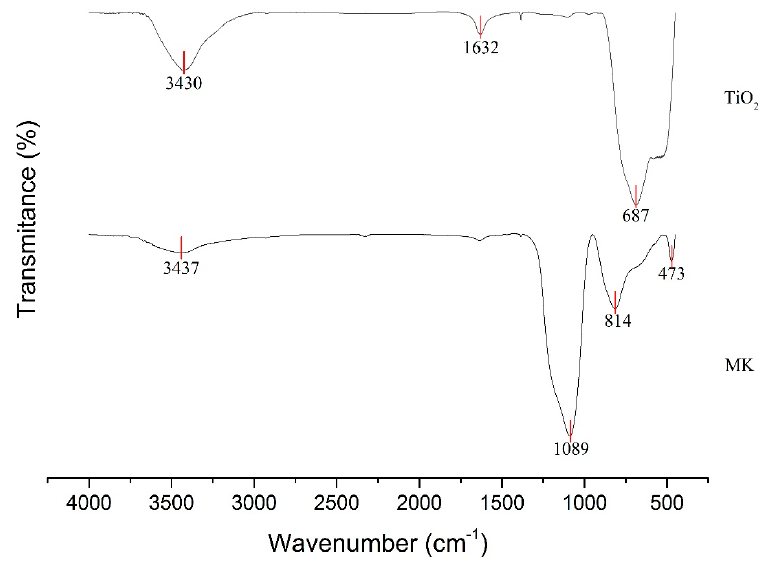
Figure 3. FTIR spectra of the raw materials.